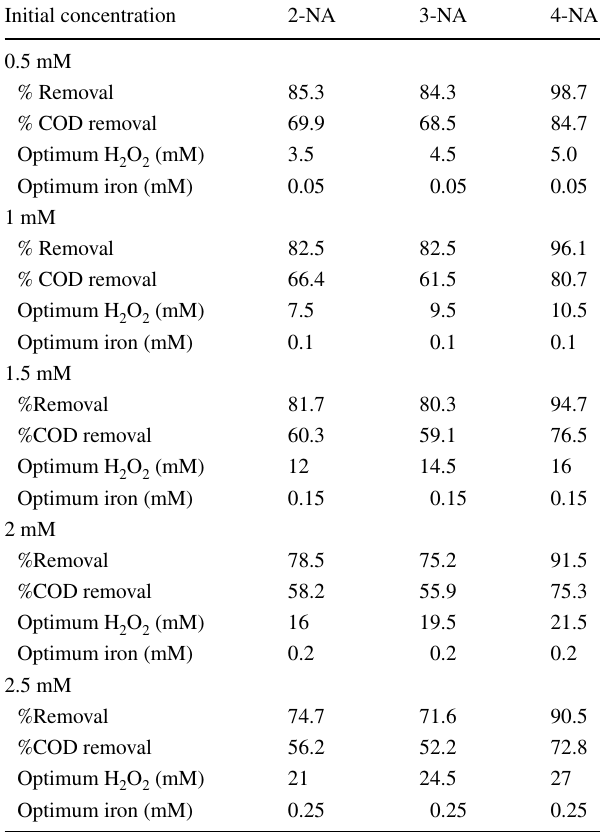
Table 1 Maximum removal efficiencies and optimum dosages of 2-NA, 3-NA and 4-NA at different initial